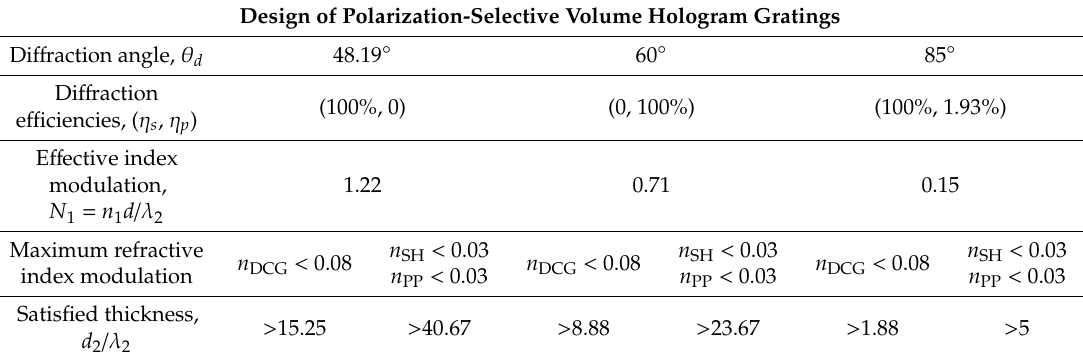
Table 2. Comparison of polarization-selective volume hologram gratings designed for various angles.